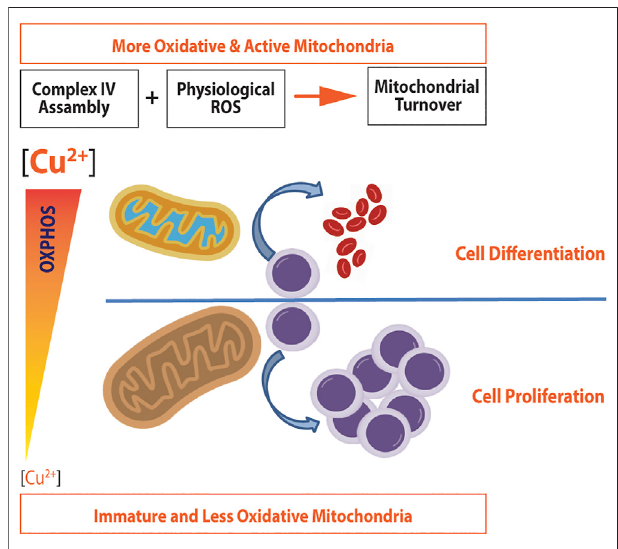
FIGURE 4 | Metabolic reprogramming induced by copper in hematopoietic stem cells. Noncytotoxic copper overload induces both the complex IV assembly and ROS generation, which promote mitochondrial turnover and biogenesis. As a result, more active and oxidative mitochondria are produced, which promote cell differentiation in HSCs. A decrease in copper concentration will down regulate the expression of complex IV, making mitochondria less oxidative. Since mitochondria will not be able to satisfy energy demands, the energy metabolism switches to glycolysis, which in turn will promote cell proliferation (adapted from Jensen et al., 2019 and Ruiz et al.,